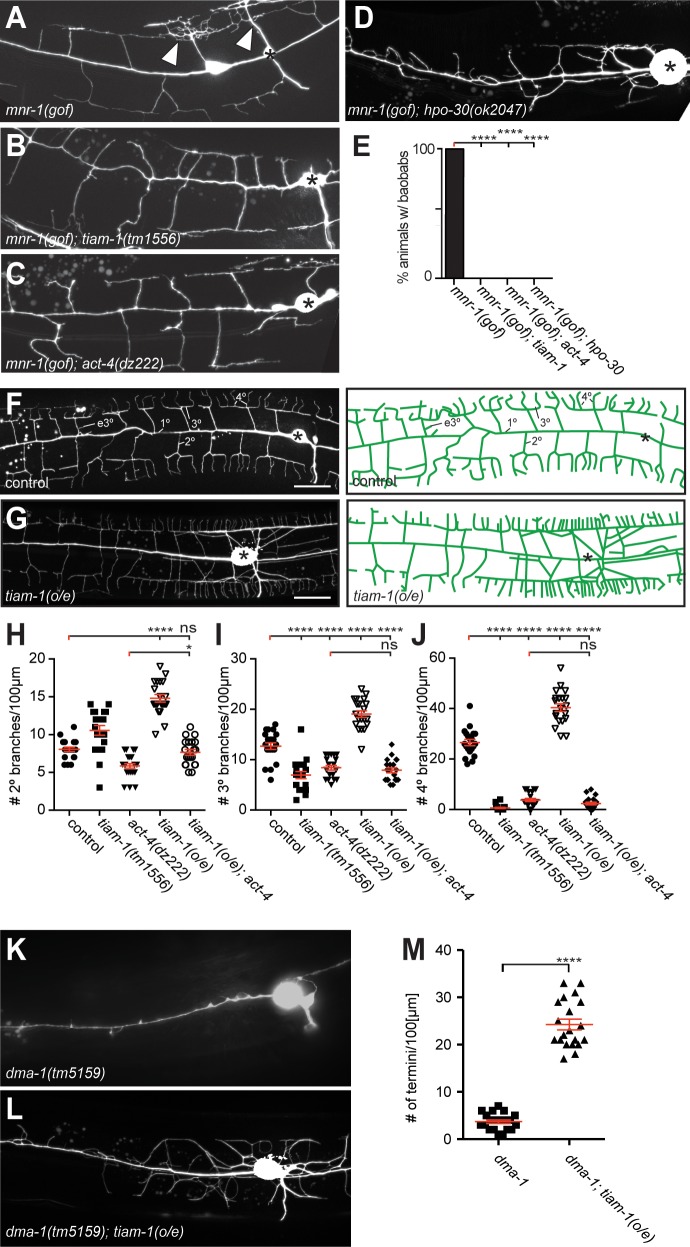
The tiam-1/GEF and act-4/Actin act downstream of the dma-1/LRR-TM receptor in PVD dendrites.(A – D) Fluorescent images of animals in which mnr-1/Menorin was expressed ectopically in muscle (mnr-1(gof): dzIs43, [myo-3p::mnr-1] (Salzberg et al., 2013)) in different genetic backgrounds. A characteristic baobab-like tree is indicated by a white arrowhead in (A). PVD is visualized by the wdIs52 [F49H12.4p::GFP] transgene in all panels. Anterior is to the left, dorsal up, and scale bars indicate 20 µm in all panels. (E) Quantification of animals with baobab-like dendritic trees in the genotypes indicated. Data are represented as mean. For raw data see Figure 1— source data 1. Statistical comparisons were performed using the Z-test. Statistical significance is indicated (****p<0.0005). n = 20 animals for all samples. (F – G) Fluorescent images of PVD (left panels) and schematics (right panels) of wild type control and tiam-1(o/e) overexpressing animals (dzIs95 [ser-2p3::tiam-1]). The control image (F) is identical to Figure 1A and shown for comparison only. (H – J) Quantification of secondary (2°, (H), tertiary (3°, (I), and quaternary (4°, (J) branch numbers per 100 µm anterior to the PVD cell body in the genotypes indicated. Data for control, tiam-1(tm1556), and act-4(dz222) are identical to data in Figure 2 and shown for comparison only. For raw data see Figure 1—source data 1. Data are represented as mean ±SEM. Statistical comparisons were performed using one-sided ANOVA with the Tukey correction. Statistical significance is indicated (ns, not significant; *, p<0.05; ****p<0.0001). n = 20 for all samples. (K – L) Fluorescent images of PVD in dma-1/LRR-TM mutant animals alone (K) and in combination with a tiam-1(o/e) expression array (L). Anterior is to the left and ventral down. Scale bar indicates 20 µm. (M) Quantification of dendrite termini in a 100 µm section anterior to the PVD cell body in the genotype indicated. For raw data see Figure 1—source data 1. Data are represented as mean ±SEM. Statistical comparisons were performed using Student’s T-test. Statistical significance is indicated (****p<0.0001). n = 20 animals for all samples.